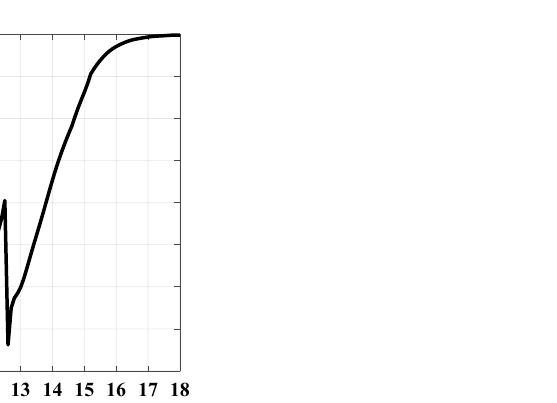
Figure 12. The phase of ( a ) co-polarization reflection for proposed unit cell and its mirror and the phase difference between them. ( b ) Cross-polarization reflection for proposed unit cell and its mirror and the phase difference between them.